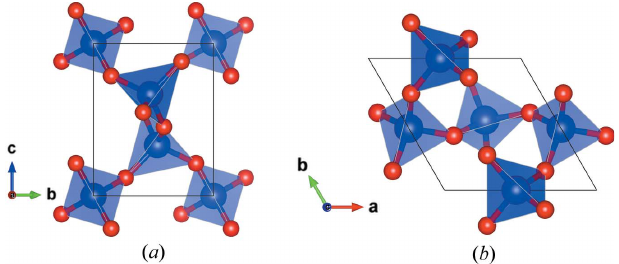
Figure 9 The structure of quartz viewed along [100] and [001] crystallographic directions. The images were produced using VESTA (Momma & Izumi, 2011).